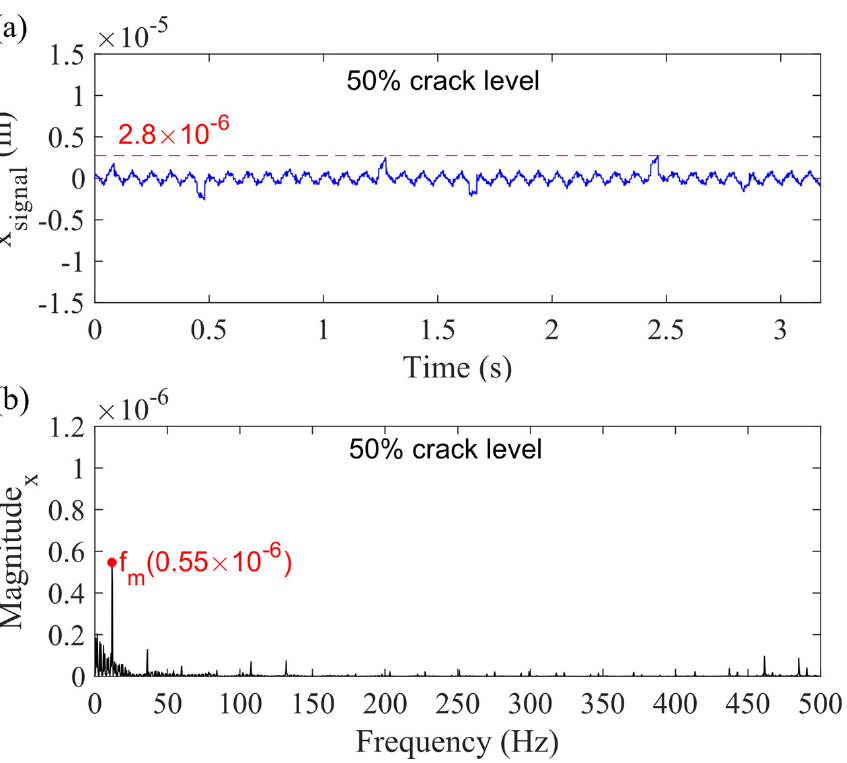
Figure 17. Sum vibration response with 50% sun gear crack level for Case 5 in ( a ) time domain and ( b ) frequency domain in x g -direction.